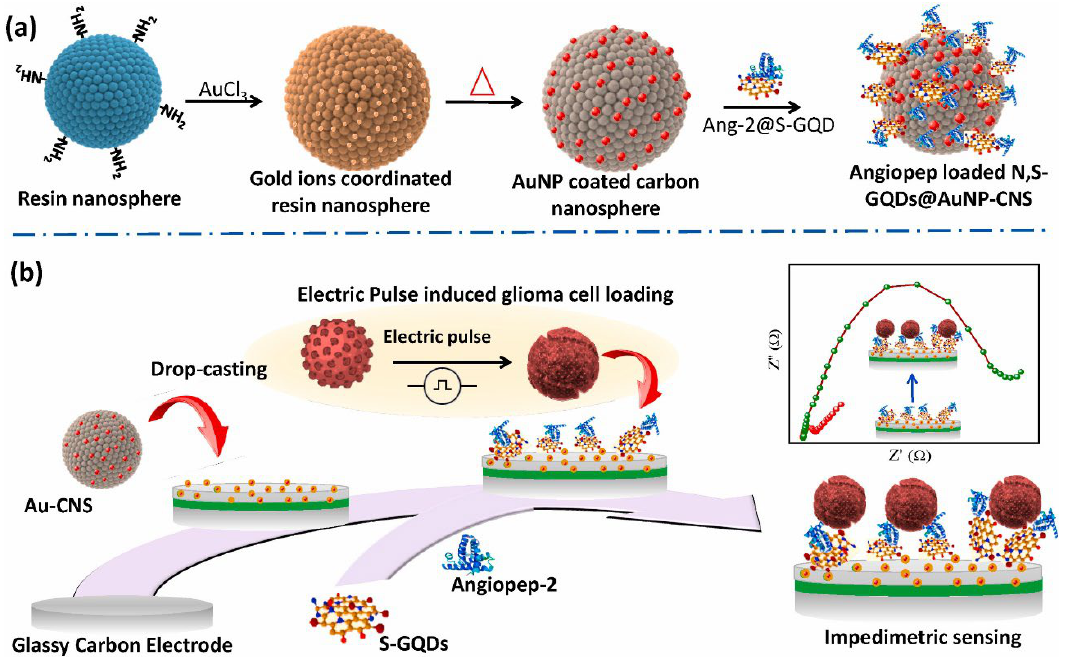
Figure 6. ( a ) Synthesis of angiopep-loaded S-GRQDs/GNP/CNSp, ( b ) Stepwise electrode fabrication and impedimetric detection of glioma cells. Reproduced with permission from [111].